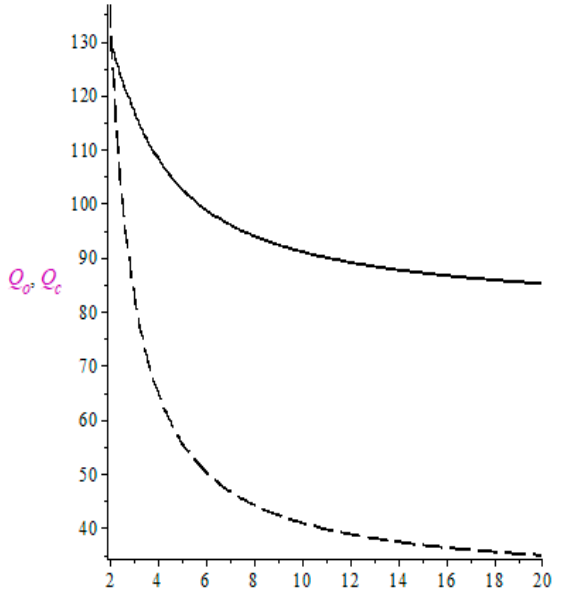
Figure 2. To calibrate Figure 2, we used the following parameter values: q = 0.8, A = 20, β = 0.09, and α = 0.3.